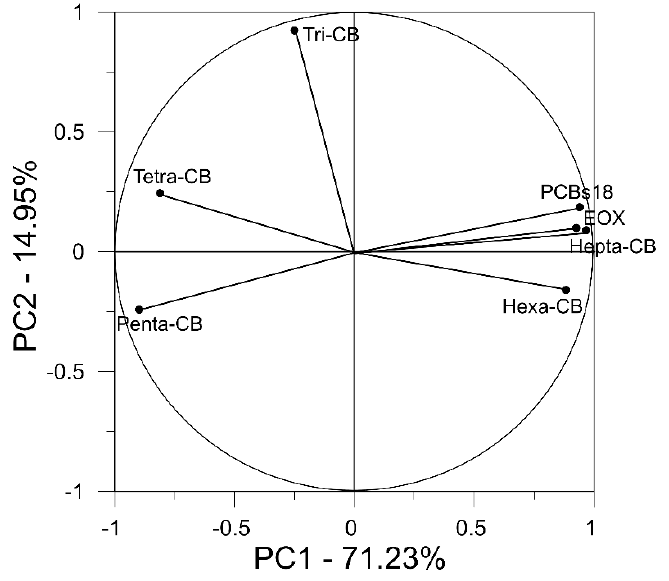
Figure 2. Contribution of EOX and PCBs to the first two principal components resulting from the application of PCA to the same parameters.